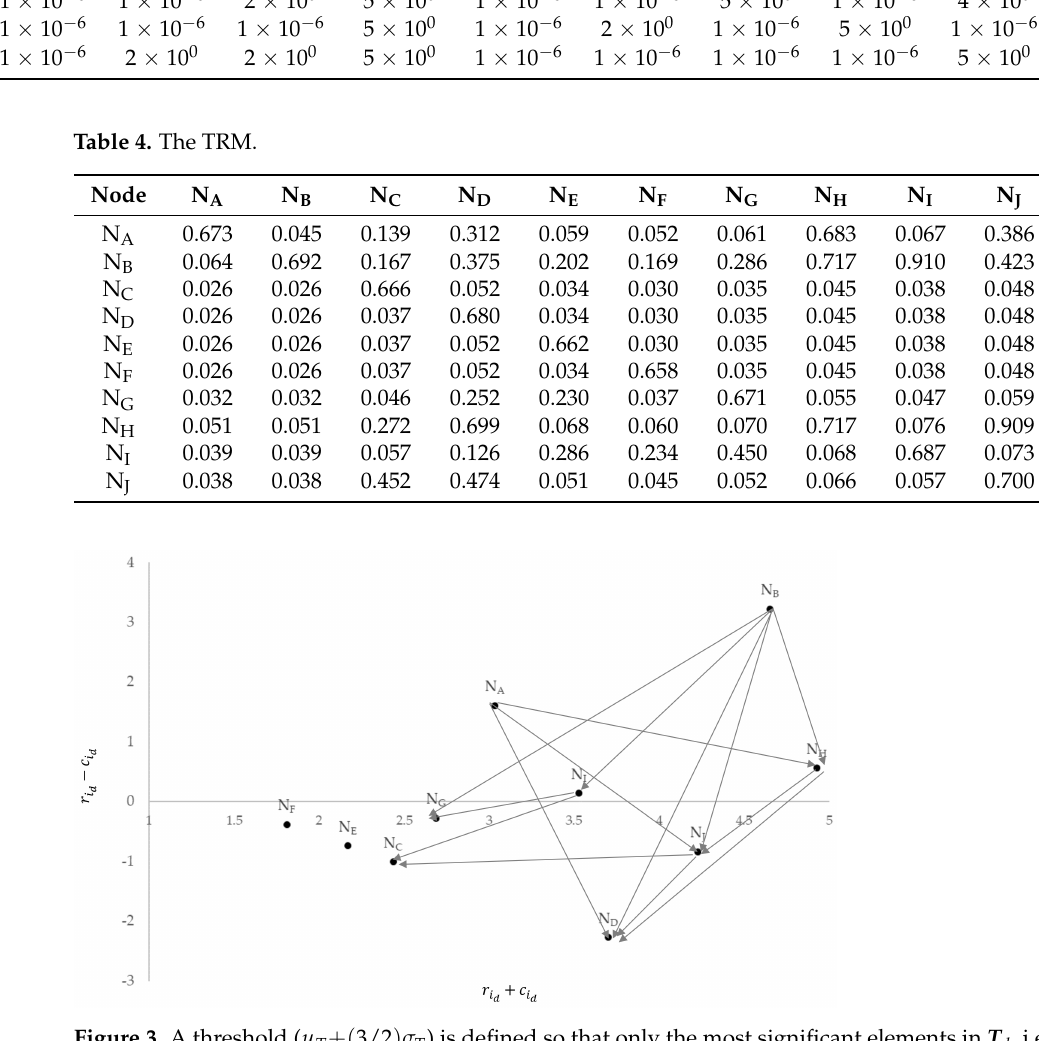
Figure 3. A threshold ( µ T +( 3/2 ) σ T ) is defined so that only the most significant elements in T d , i.e., those elements with total relation values ( t i ) greater than the threshold, are d j d